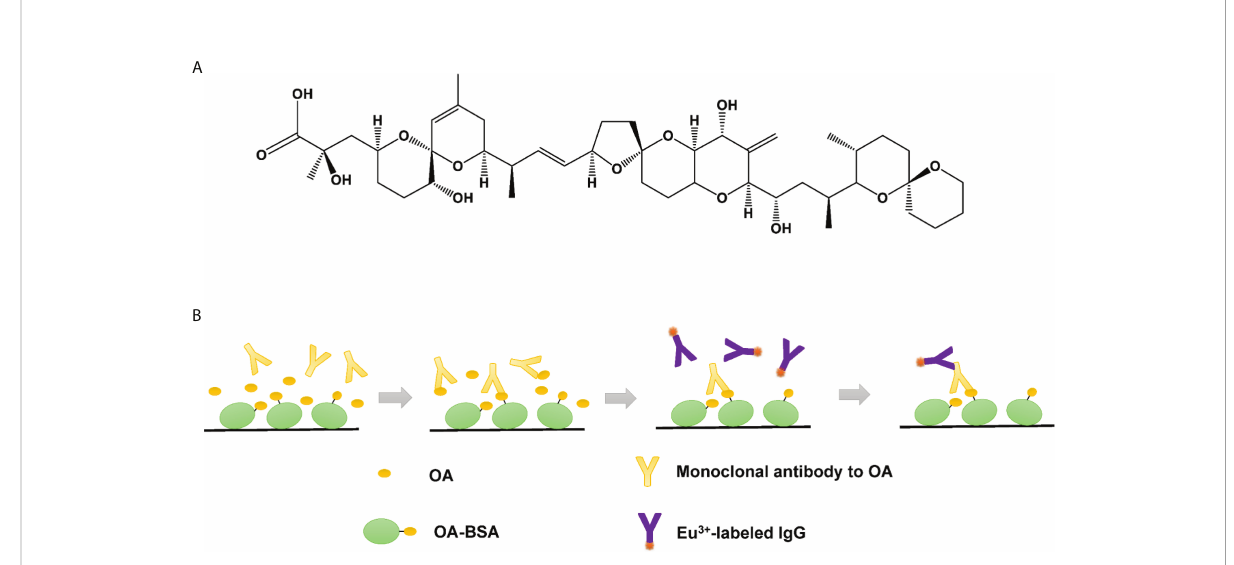
FIGURE 1 (A) Molecular formula of OA. (B) Schematic of TRFIA system for OA